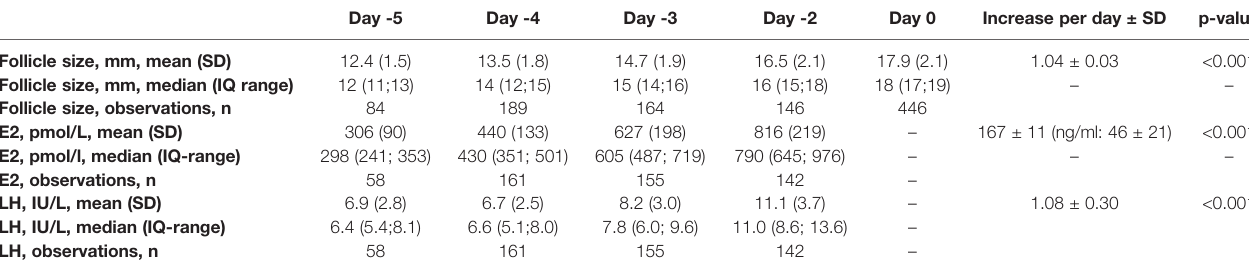
TABLE 2 | Follicle sizes and E2 and LH concentrations on day -5 to day -2 (day -2 = day of trigger) and average increases per day.